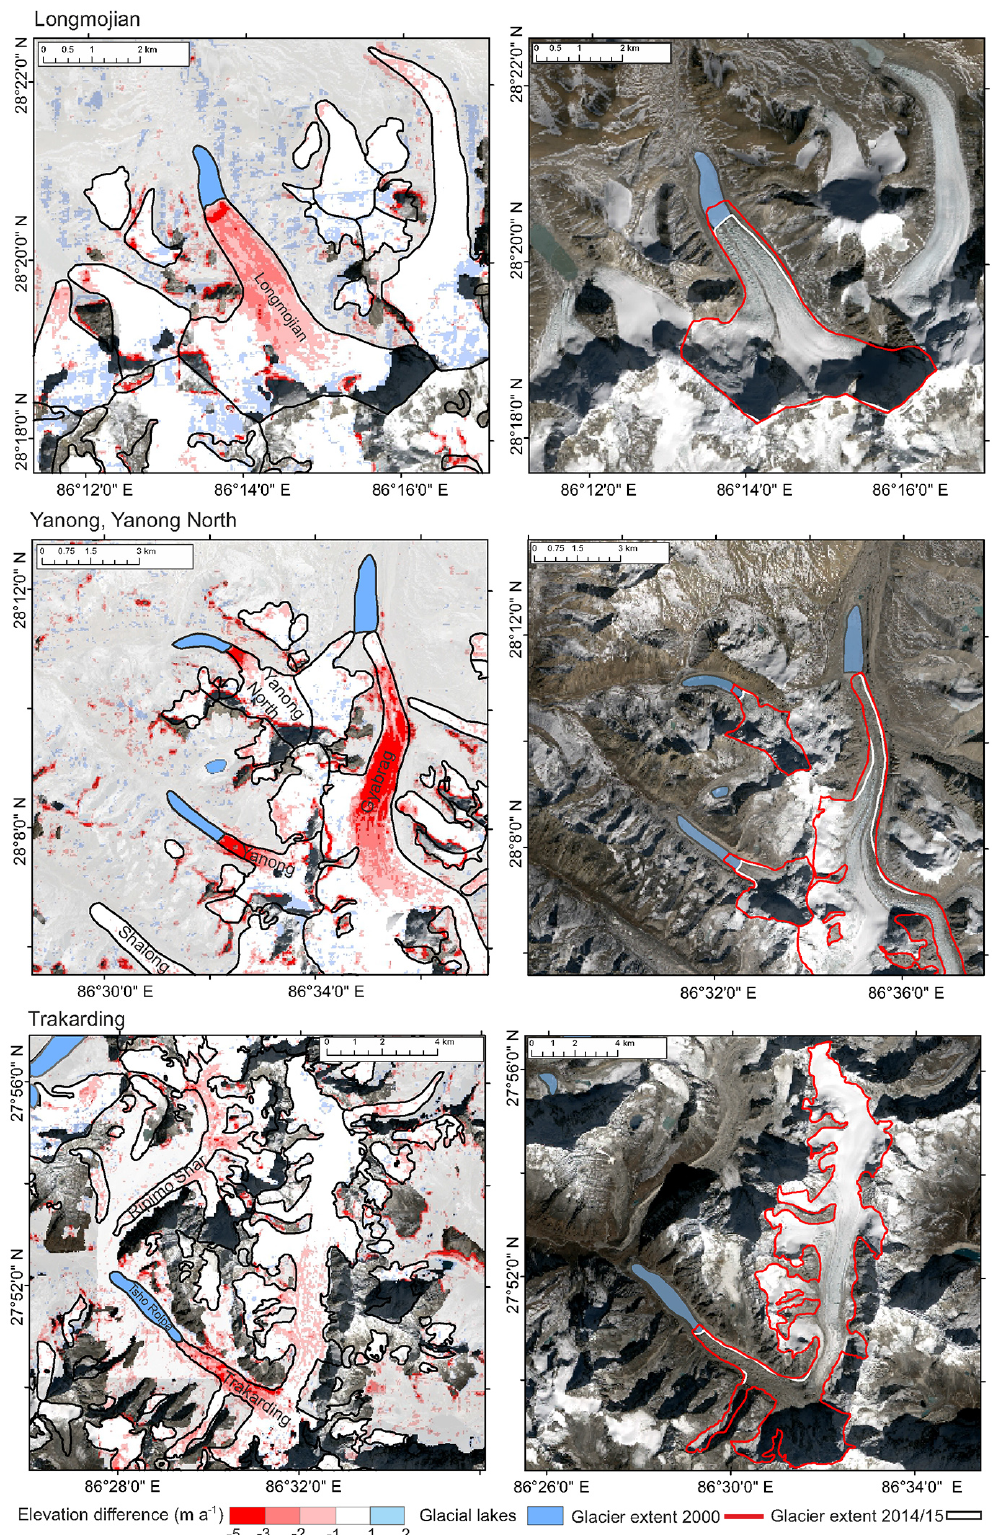
Figure 3. Examples of surface elevation change and total area change over the study period on lacustrine-terminating glaciers. Semi- transparent, off-glacier differences are also